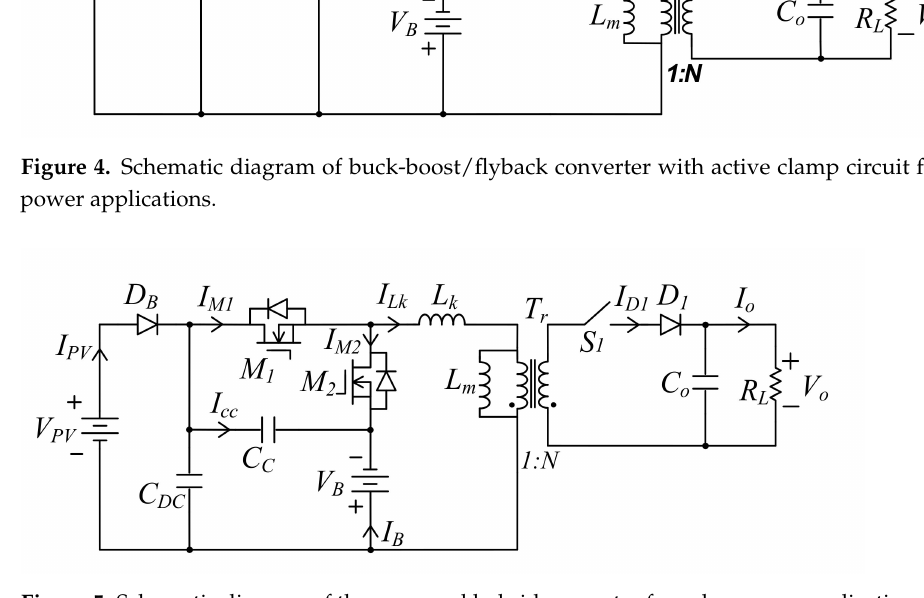
Figure 5. Schematic diagram of the proposed hybrid converter for solar power